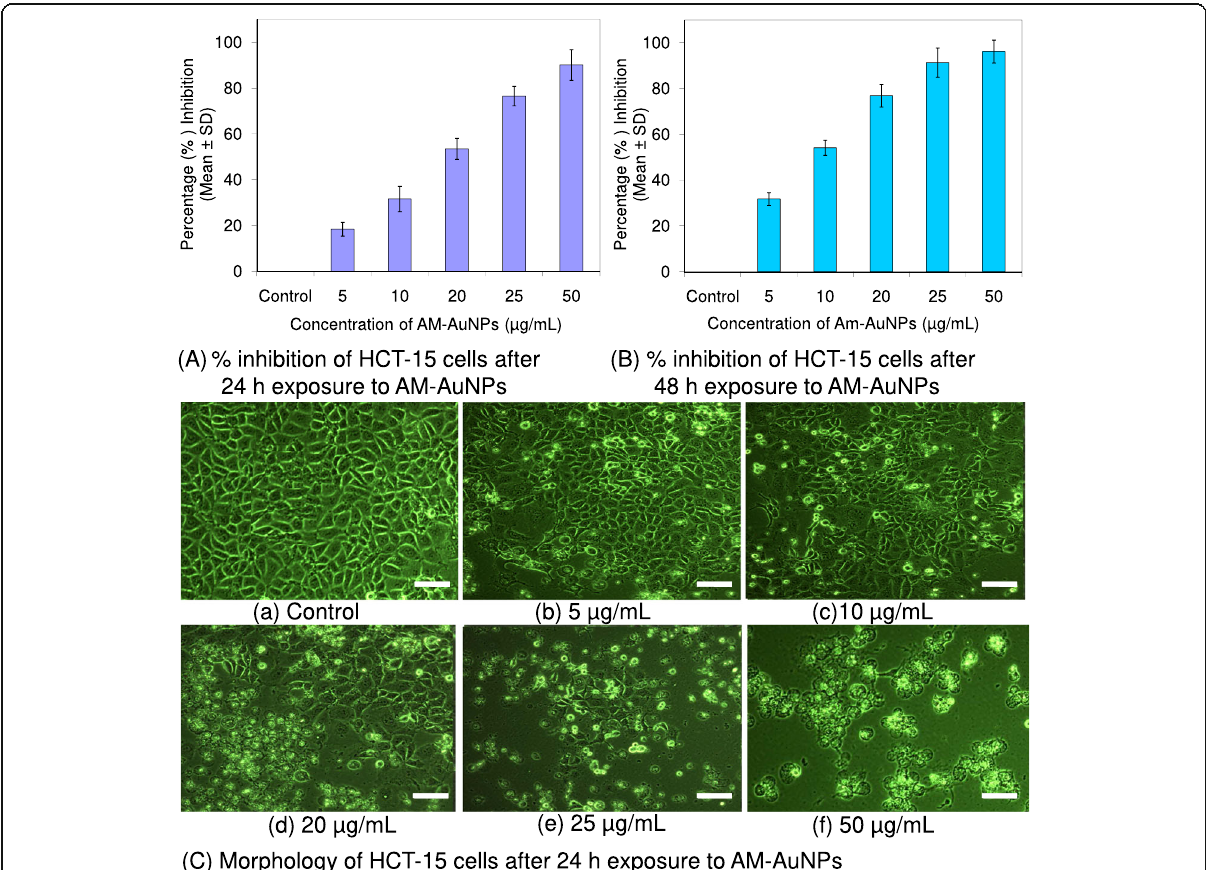
Fig. 4 Representative histogram showing percentage growth inhibition of HCT-15 cells after ( A ) 24 h and ( B ) 48 h of exposure to biogenic AM- AuNPs at 5, 10, 20, 25, and 50 μ g/mL concentrations. The results represent the means of three independent experiments. Error bars represent the standard deviation of means. ( C ) Morphology of HCT-15 cells after 24 h exposure of AM-AuNPs with different concentrations (a) control; (b) 5 μ g/ mL; (c) 10 μ g/mL; (d) 20 μ g/mL; (e) 25 μ g/mL; and (f) 50 μ g/mL. All images are captured at × 20 magnification with phase contrast